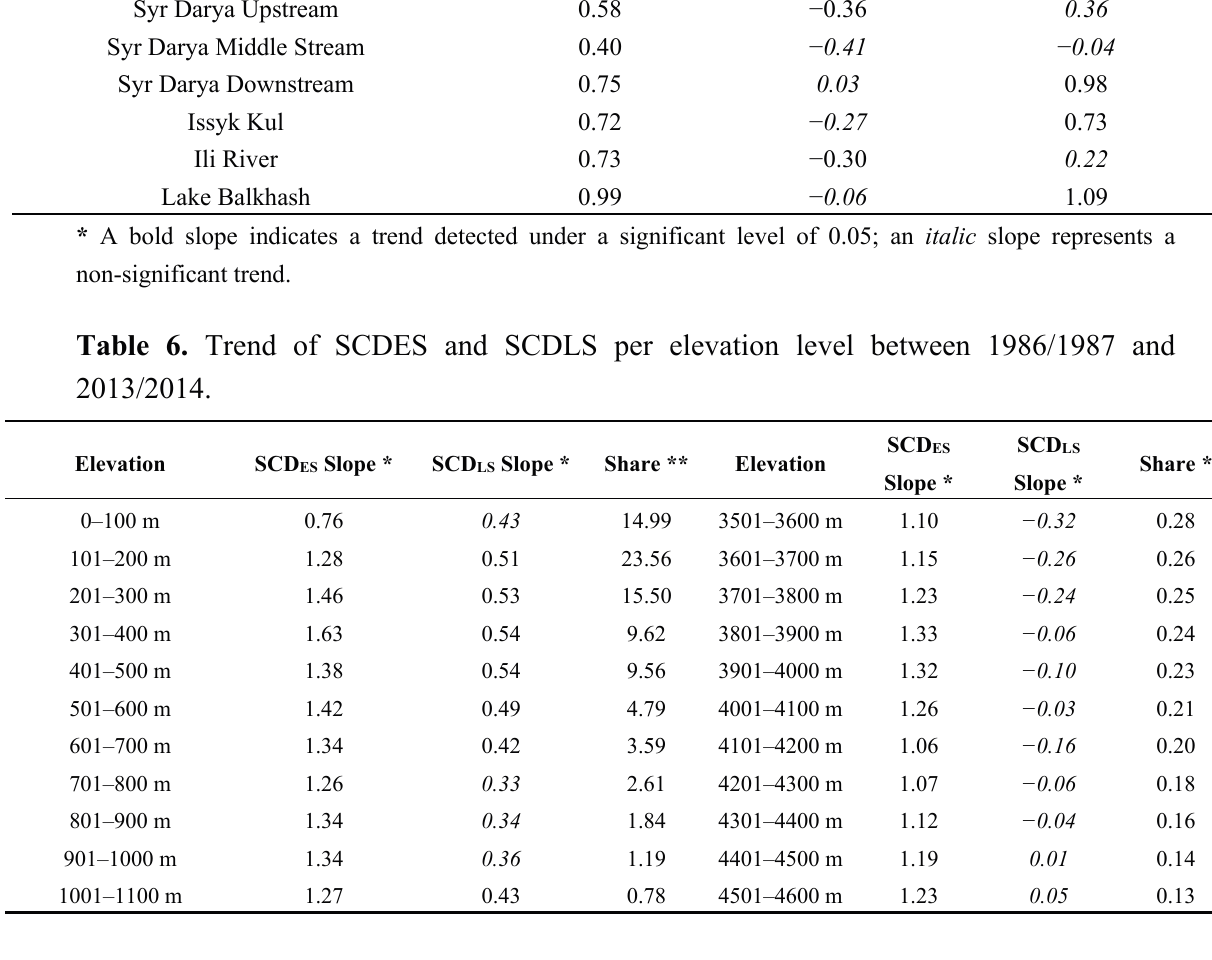
Table 5. Trend of SCD ES and SCD LS per catchment group between 1986/1987 and 2013/2014. Catchment SCD ES Slope * SCD LS Slope * SCD Slope * Amu Darya Upstream 0.57 − 0.40 0.44 Amu Darya Middle Stream 0.22 − 0.32 0.03 Amu Darya Downstream 0.25 0.17 0.49 Syr Darya Upstream 0.58 − 0.36 0.36 Syr Darya Middle Stream 0.40 − 0.41 − 0.04 Syr Darya Downstream 0.75 Issyk Kul 0.72 − 0.27 Ili River 0.73 Lake Balkhash 0.99 − 0.06